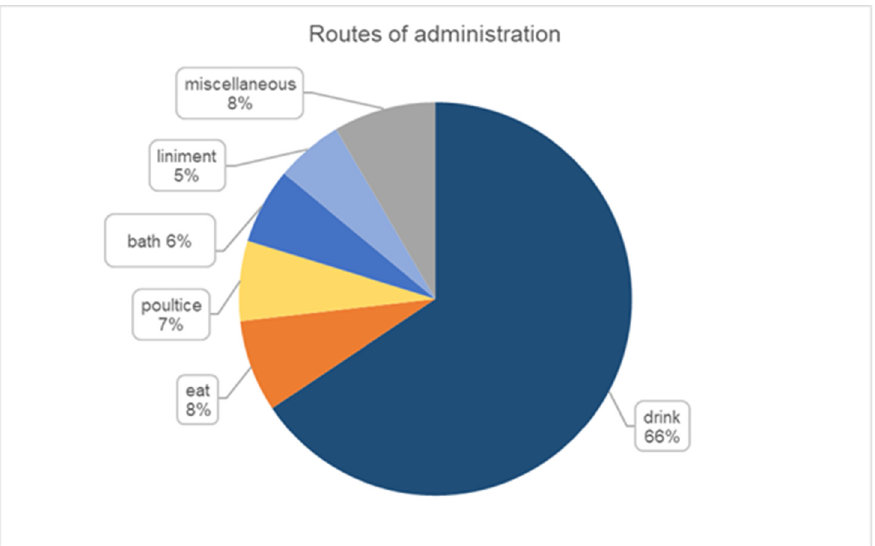
Figure 5. Percentages of use reports for different routes of administration of medicinal legume species from Thailand, mentioned in 152 primary data sources produced from 1986–2019.